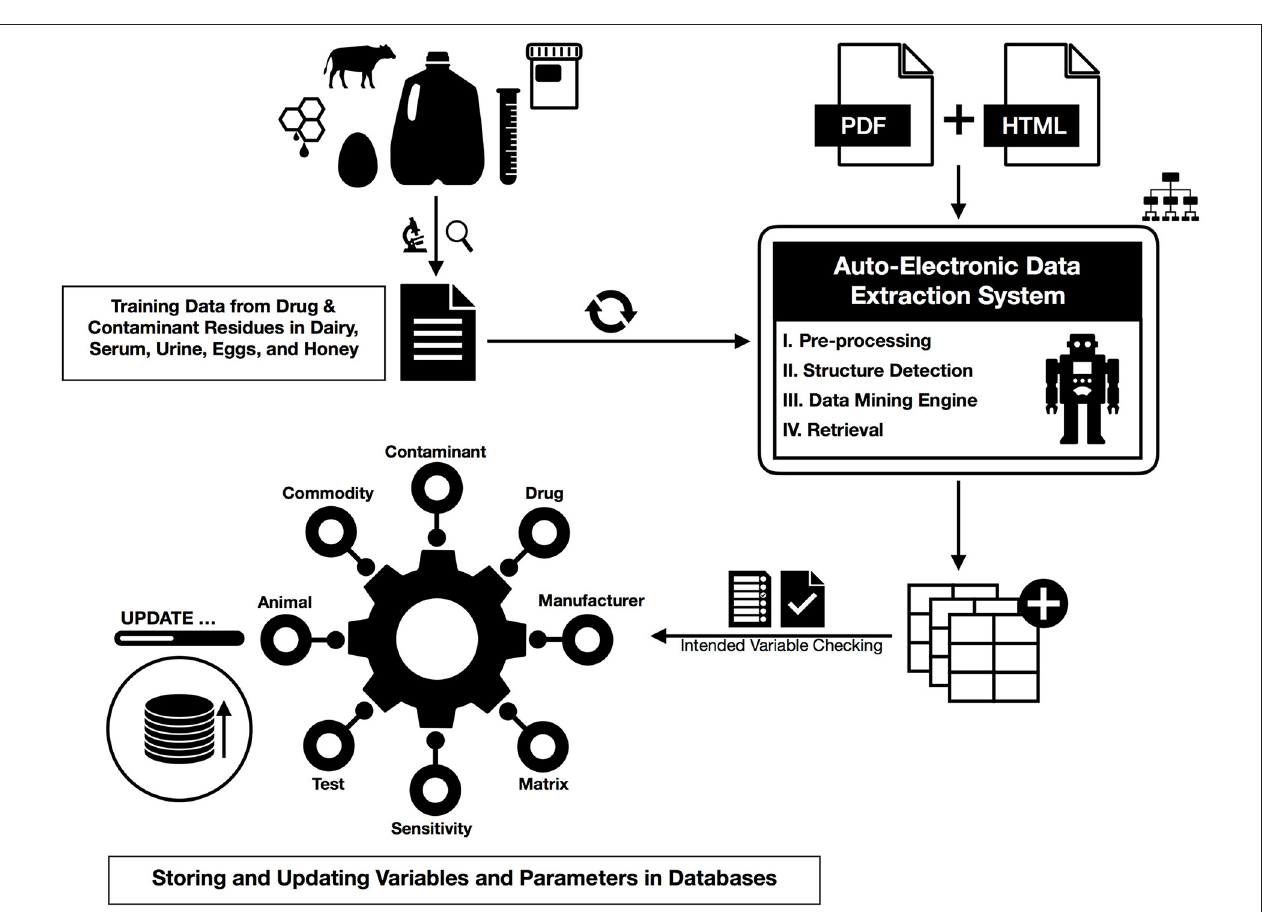
FIGURE 1 | The action workflow of text mining for HTML and PDF documents from preprocessing and dictionary creation to storing tables in the